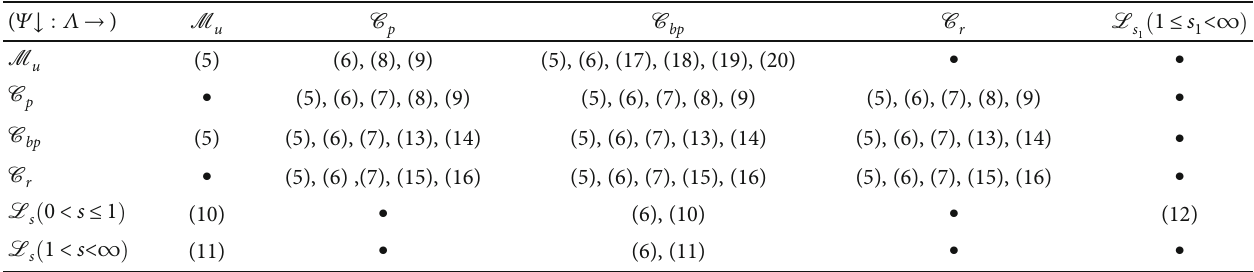
g , C , C , C , L u p bp r s